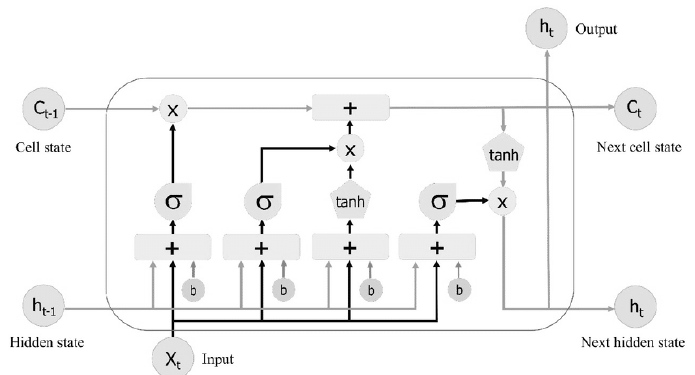
Figure 8. A module of LSTM network